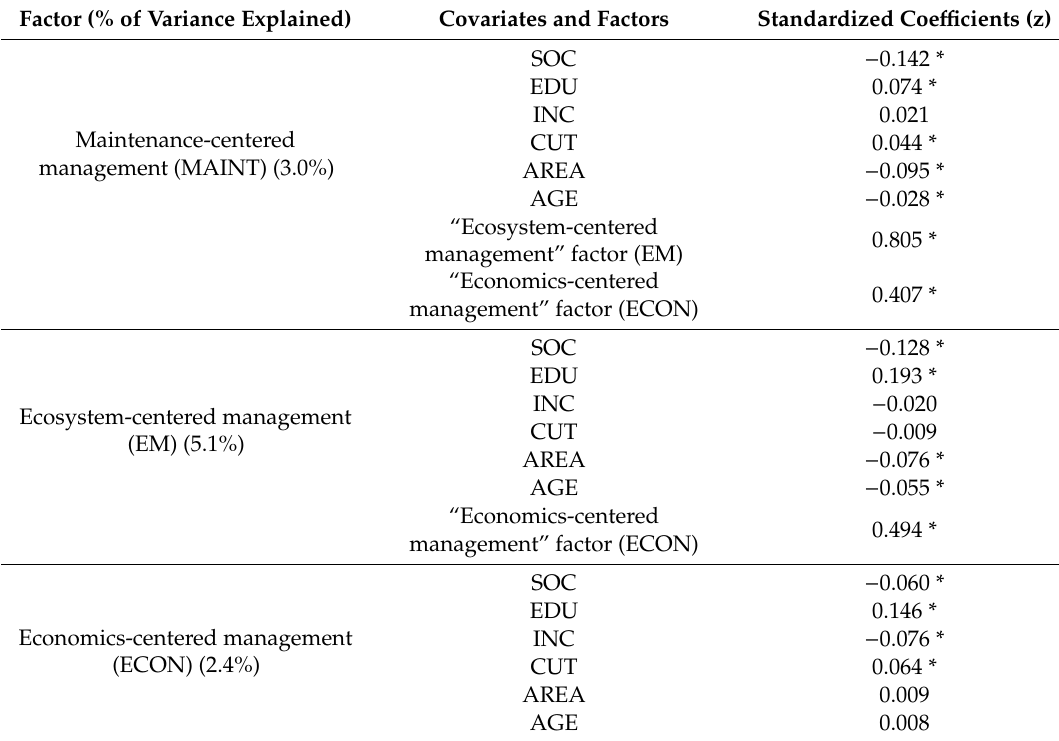
Table 3. E ff ects of the covariates on three factors representing conceptualizations of forest management, and the correlations between the conceptualizations, estimated with the multiple indicators multiple causes (MIMIC) model. Statistically significant parameters at the 5% level or better are marked with *. Factor (% of Variance Explained) Covariates and Factors